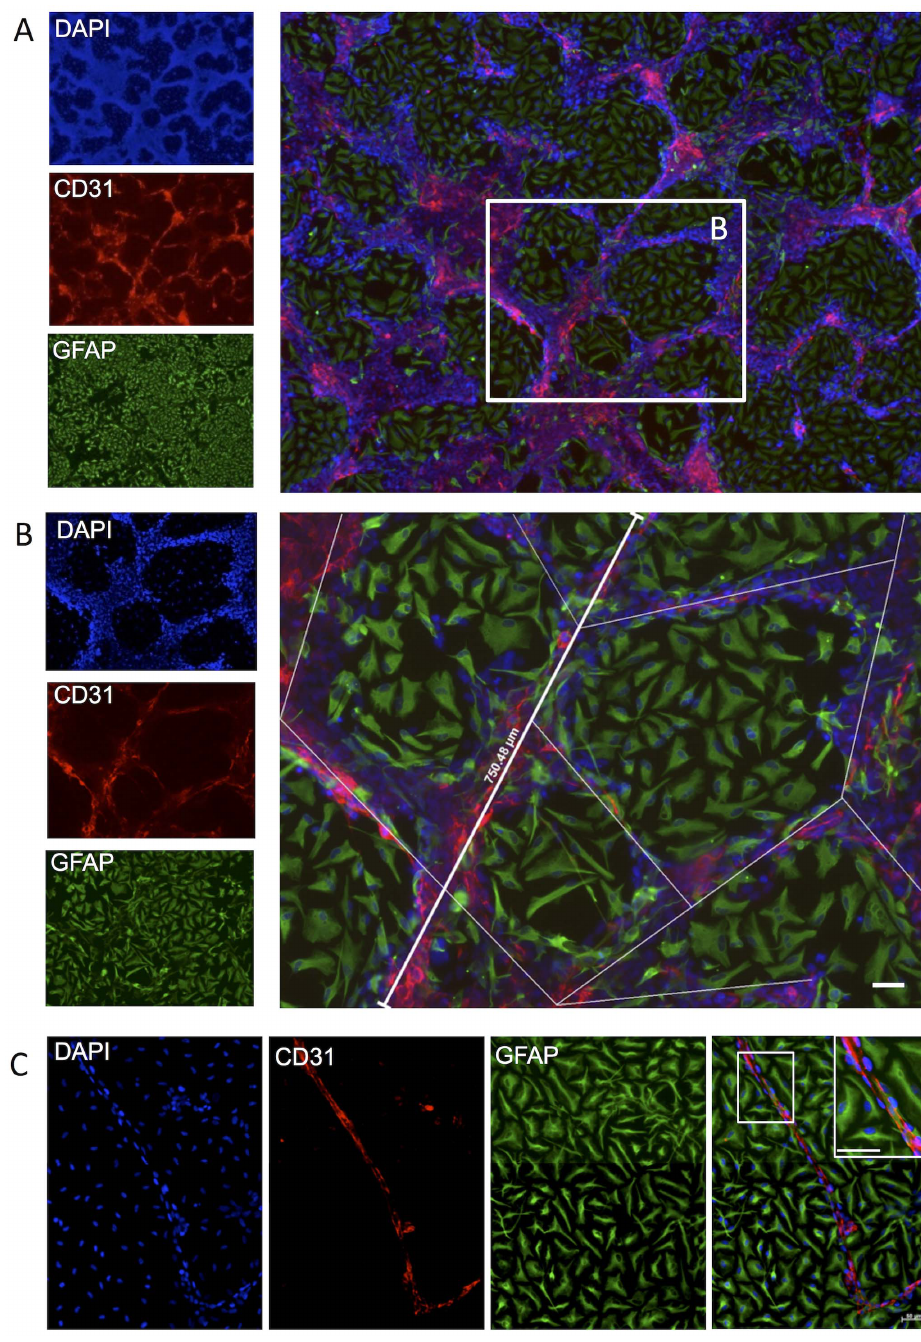
Figure 3. Immunohistochemistry of junctional markers on endothelial cells. Localization of ZO1 expression/detection was heterogeneous, with it being only visible as part of the membrane (i.e. cellular junctions) on elongated and arranged endothelial cells (red arrows), but being mostly cytoplasmic in clumped and non-elongated cells (yellow arrows). As the cytoplasmic expression is decreased (grey arrow), it gradually shifts towards being exclusively present in the membrane.